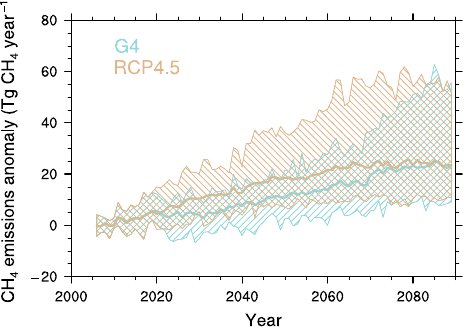
Fig. 4 Changes in permafrost methane emissions. Projected annual methane (CH 4 ) emissions relative to the fi rst fi ve years (2006 – 2010) of the simulations under the emission scenario RCP4.5 and the geoengineering experiment G4. Thick lines show ensemble mean values and hatched areas show the across-ESMs range. The CH 4 fl uxes in the permafrost region are inferred from the anoxic respiration rates in the inundated